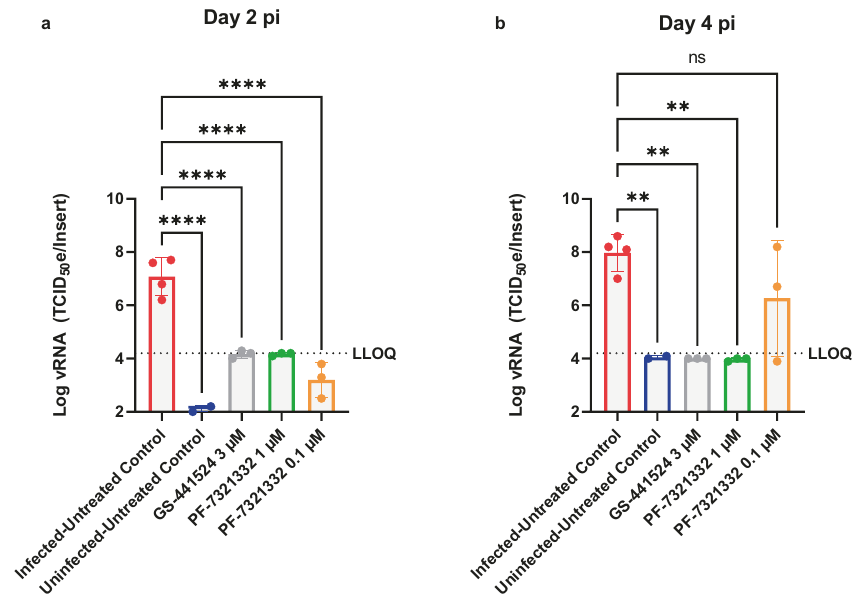
Fig. 1 Antiviral activity of PF-332 in human airway epithelial cells infected with SARS-CoV-2 B1.1.7. Human airway epithelial cells, fully differentiated in an air-liquid culture system, were treated with compound at the basal site starting 1 h before infection with SARS-CoV-2 B.1.1.7 (alpha variant). Infection was done at the apical site. On a day 2 and b day 4 post viral RNA in culture supernatant was quanti fi ed. Each drug-treated condition is from 3 independent cultures. The infected/untreated control is from 4 independent cultures and the uninfected/untreated control from 2 independent cultures. Data in a , b represented as mean ± SD. Asterisks in a , b indicate the statistical signi fi cance between treated samples and the infected-untreated control. * P < 0.05, ** P < 0.01, *** P < 0.001, **** P < 0.0001 (one-way ANOVA). Pi post-infection. Source data are provided as a Source Data fi